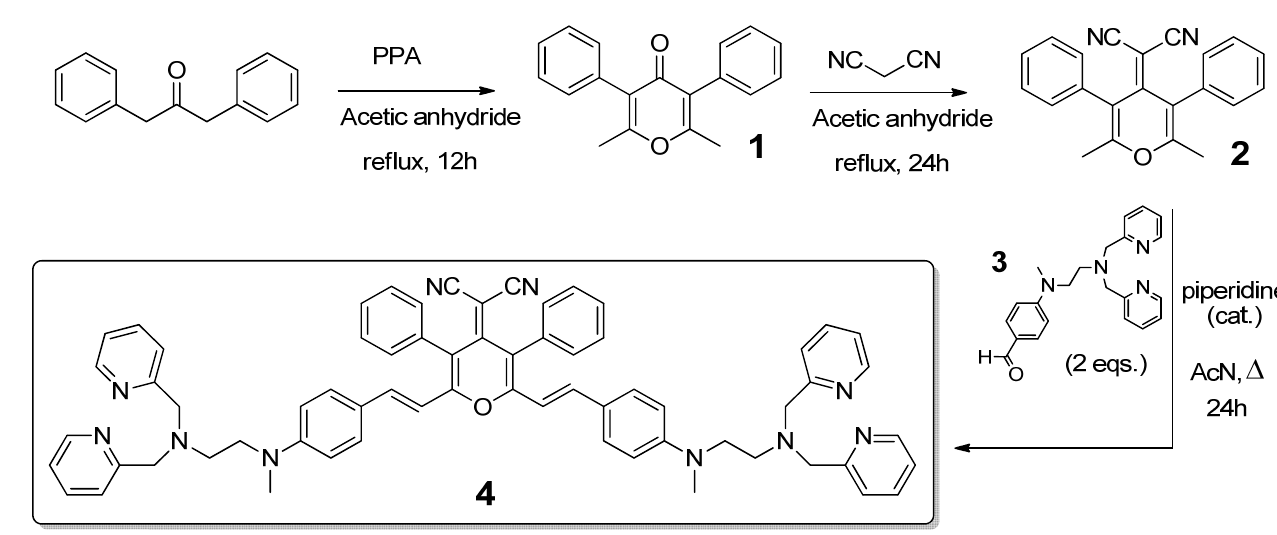
Figure 1. Full synthesis of chemosensor 4 .